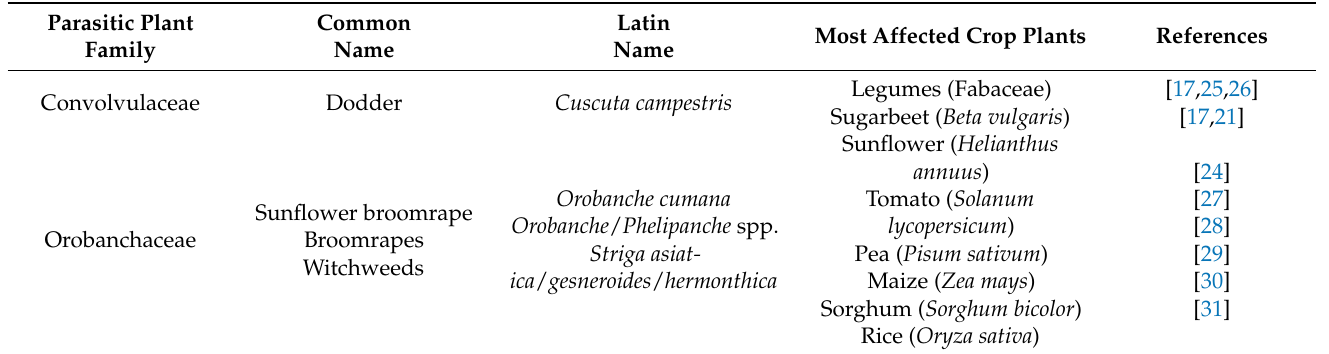
Table 1. List of the most damaging parasitic plants and their main affected crop